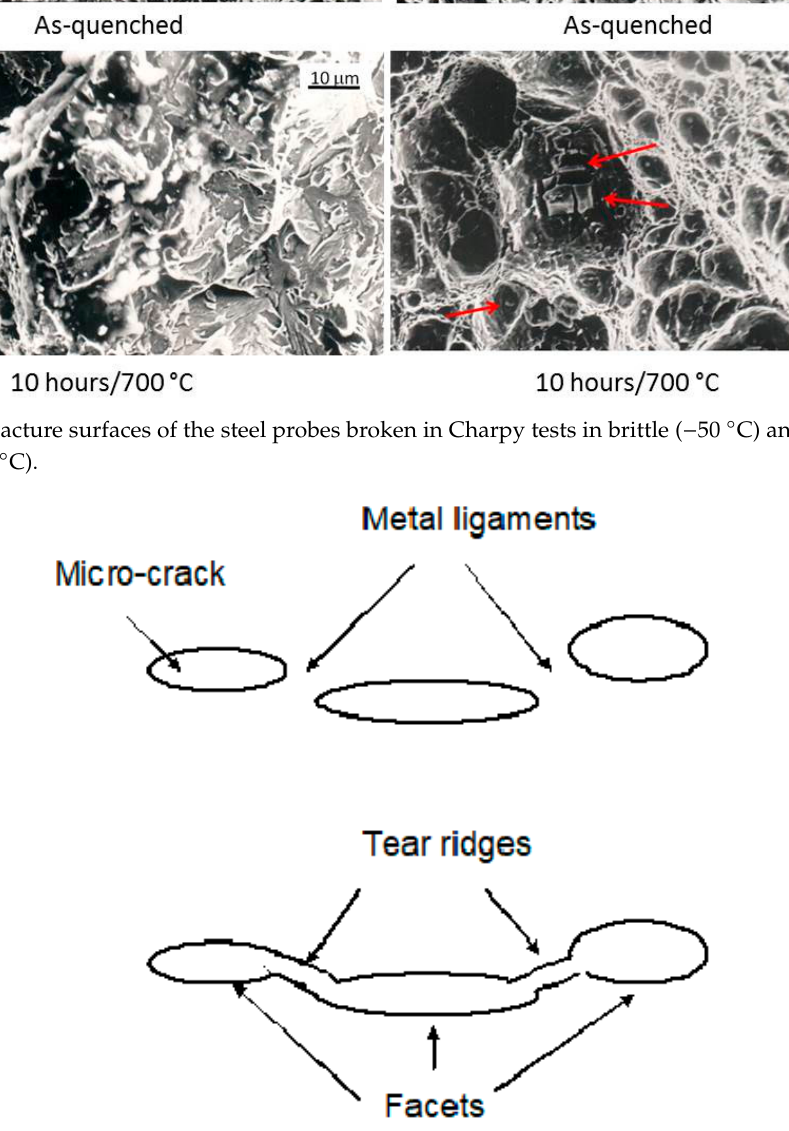
Figure 6. Schematic view of the coalescence process of micro-cracks in quasi-cleavage fracture mode.